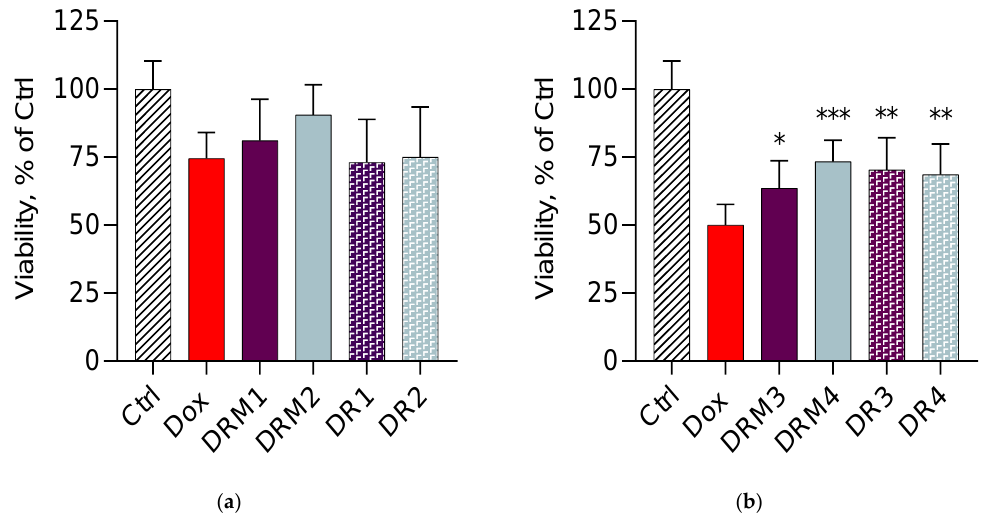
Figure 8. In vitro cytotoxic effect of pure doxorubicin in H9c2 cells after 24 h treatment.